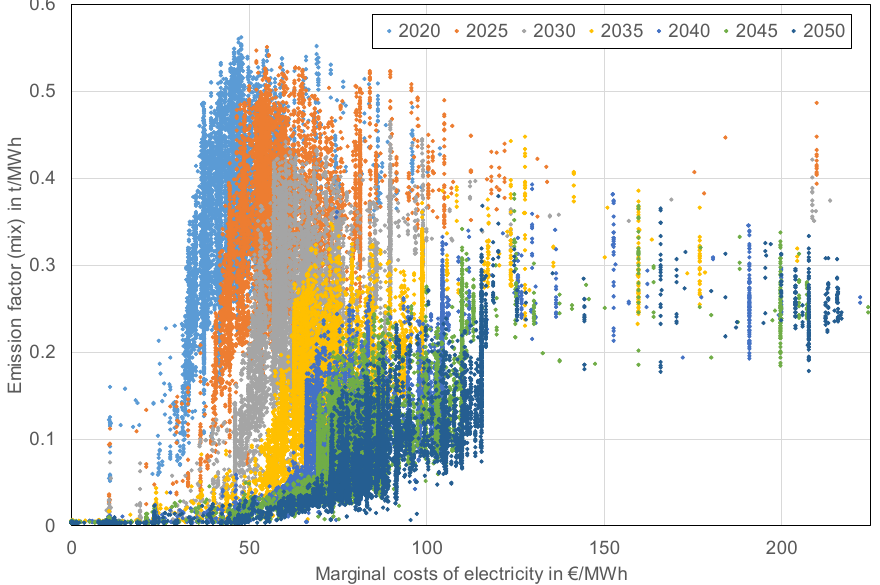
Figure 12. Hourly emission factors of electricity (mix, Carnot) and marginal costs of electricity.